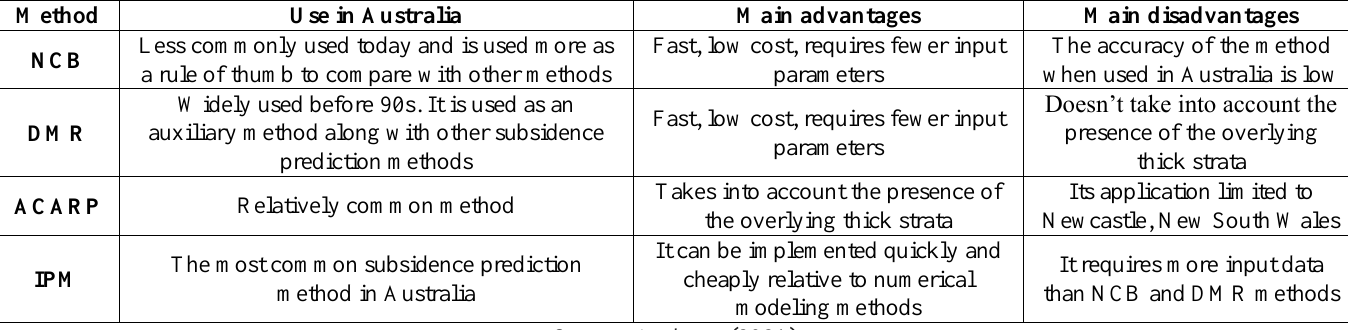
Table 7: Summary of the most applicable empirical methods for prediction of mine subsidence in Australia. Method